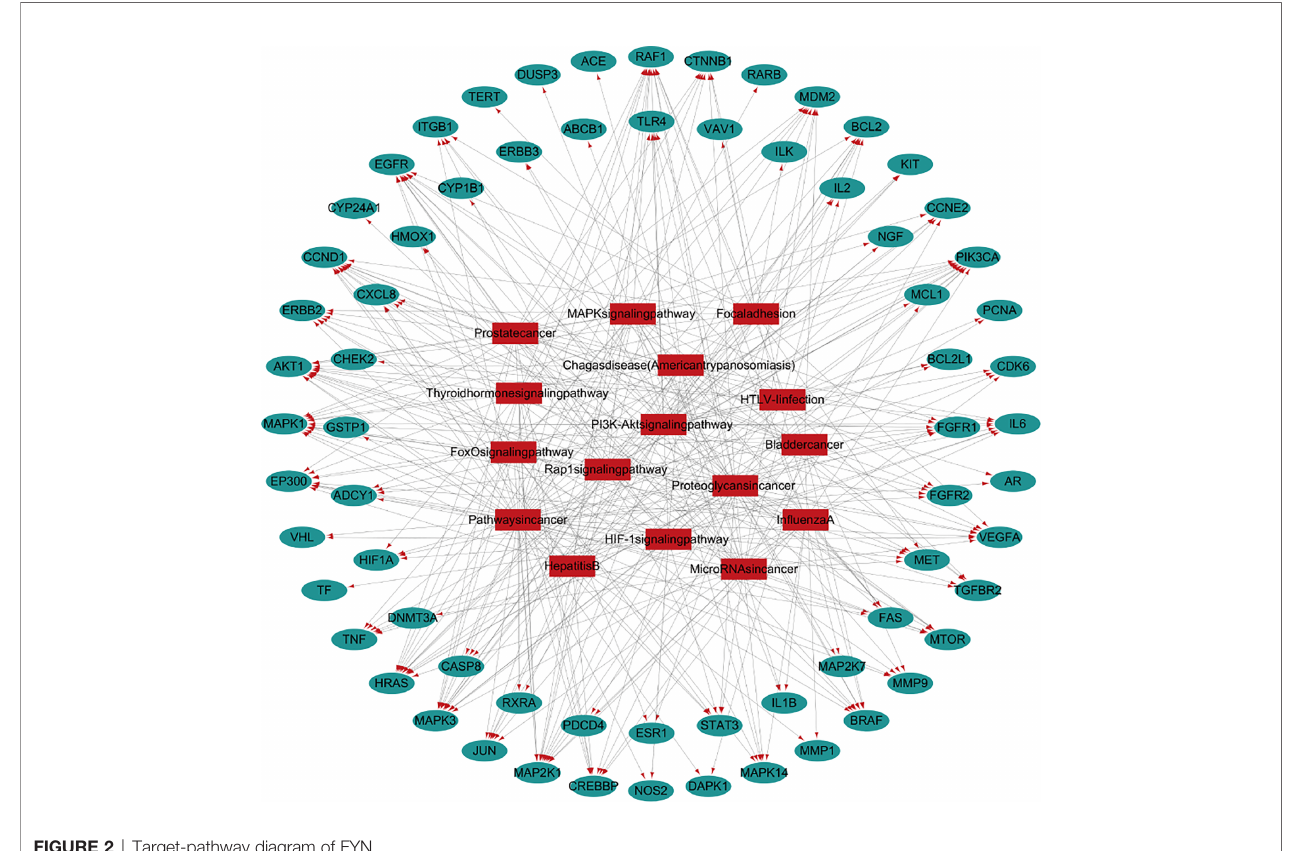
FIGURE 2 | Target-pathway diagram of FYN.